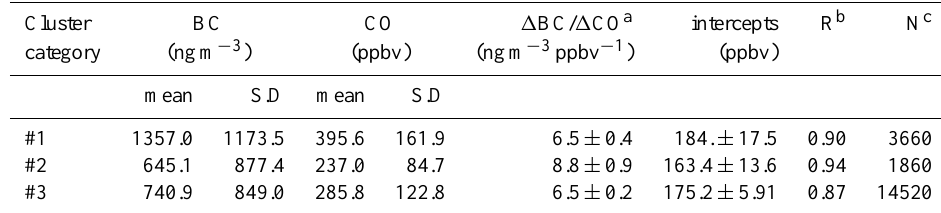
Fig. 4. Footprint regions of air masses 48-h back trajectories using ensemble approach (a, b, c) and a scatter plot of the BC-CO correlation for each cluster (d) . Shading colors (unit: natural logarithm of residence hour in each grid) in the plots indicate the possible source region of pollution. The size of circle represents the yearly mean PM 10 mass concentration for the metropolis (population over 1 million) included in the footprint region. Table 1. Statistical results of BC and CO concentrations and BC-CO correlations for each cluster.